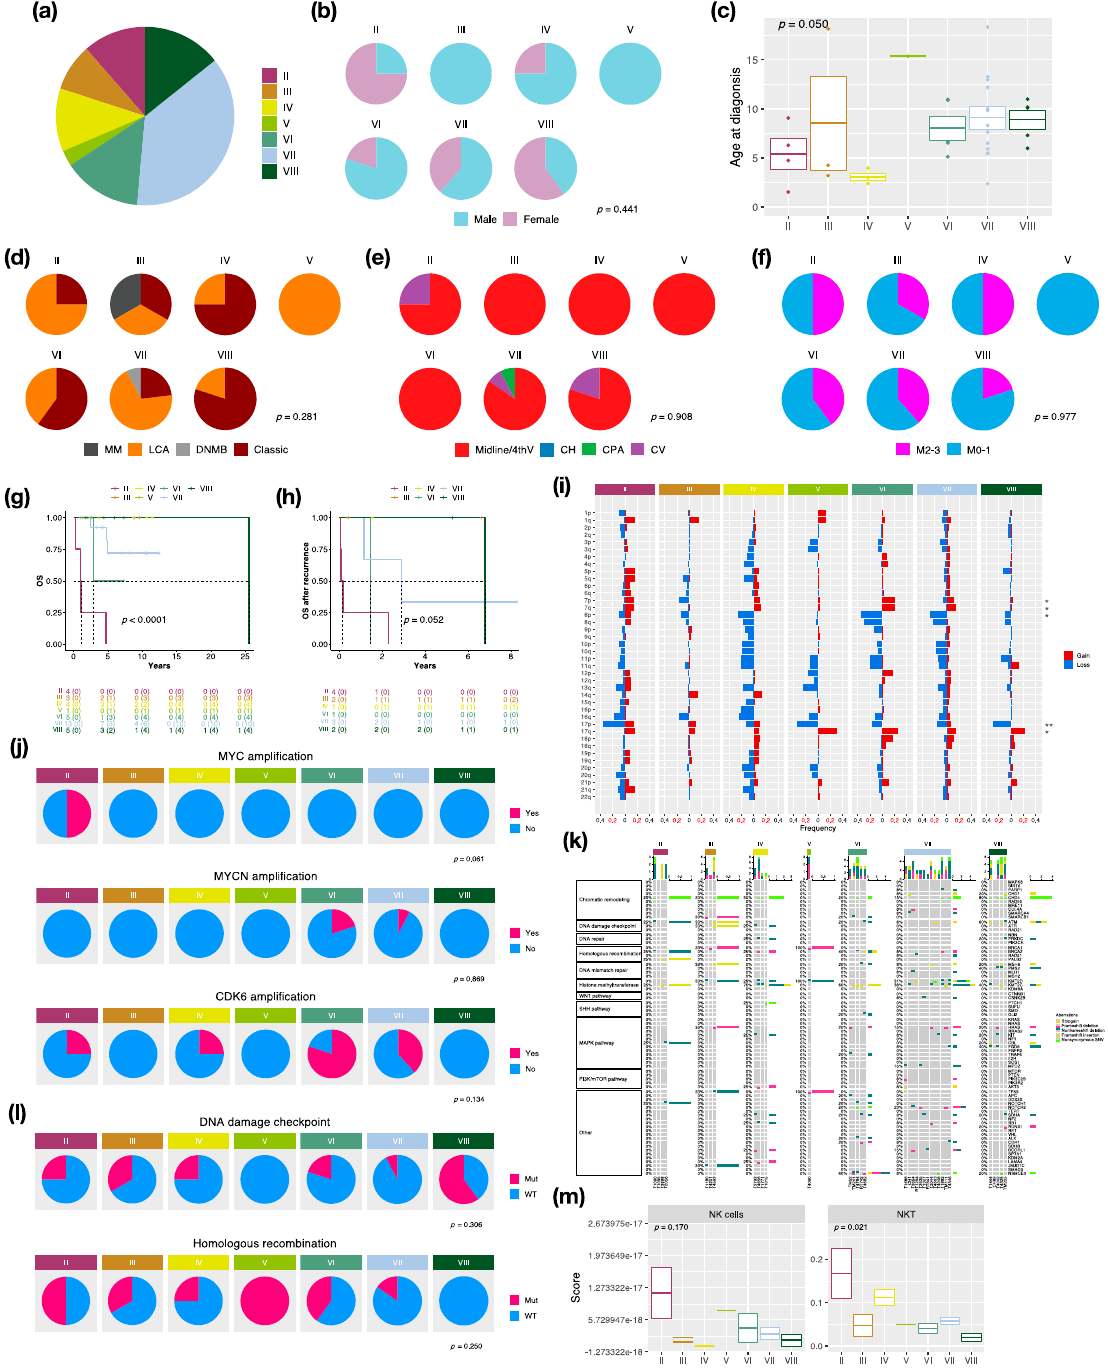
Figure 4. Characteristics in non-WNT/non-SHH MB subtypes. ( a ) the proportion of non-WNT/non- SHH subtypes. Clinical features including gender ( b ), age ( c ), histology ( d ), tumor location ( e ), me- tastasis ( f ) in non-WNT/non-SHH subtypes. DNMB: desmoplastic/nodular medulloblastoma, LCA: large-cell/anaplastic, MM: medulloblastoma with melanotic myogenic differentiation,